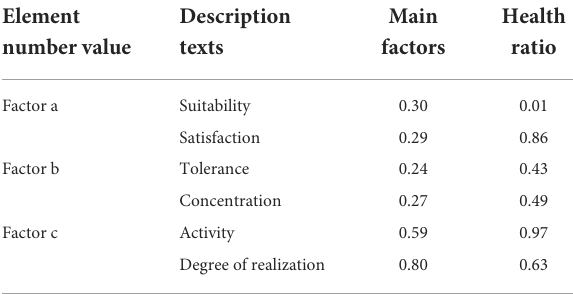
TABLE 2 Description of mental health